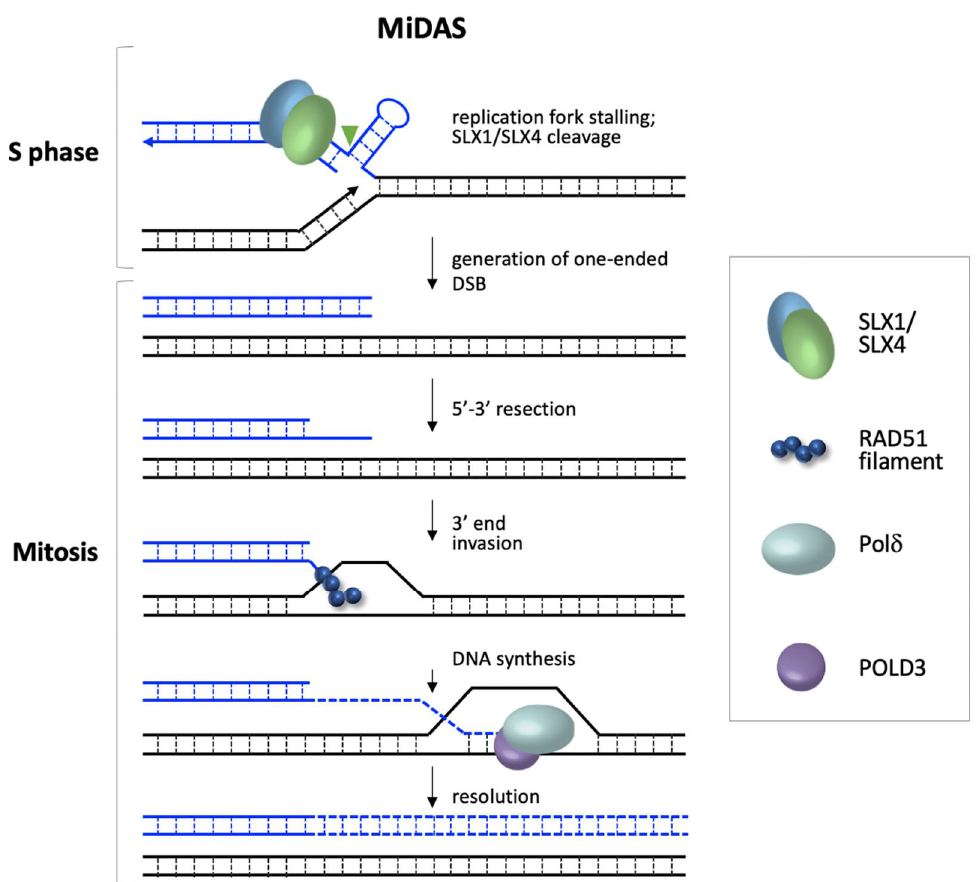
Figure 1. Model for mitotic DNA synthesis (MiDAS) at the FMR1 locus. FM alleles with stalled replication forks that have not been resolved by the time mitosis begins are cleaved by the SLX1/SLX4 nuclease to generate a one-ended DSB. After end resection to generate a 3′ overhang, binding of RAD51 allows the exposed 3′ end to invade a homologous template, likely a sister chromatid. Conservative DNA synthesis then occurs in a POLD3-dependent fashion to complete replication [48]. Failure to initiate this process results in the formation of ultrafine bridges and the high frequency loss of the affected X chromosome [26,48], while failure to complete MiDAS results in fragile site expression [48].